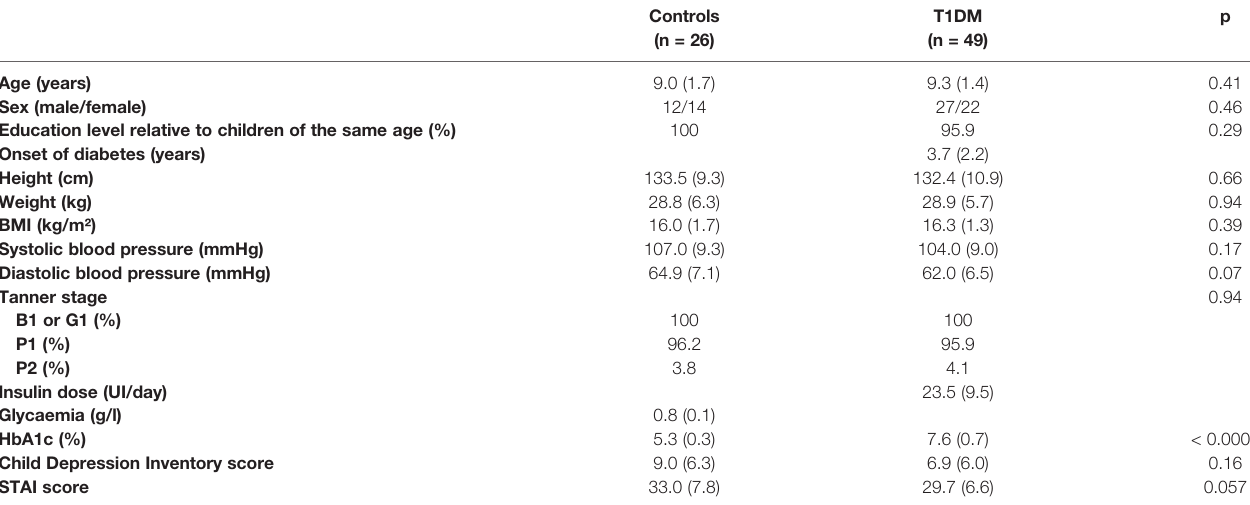
TABLE 1 | Characteristics of the study population at